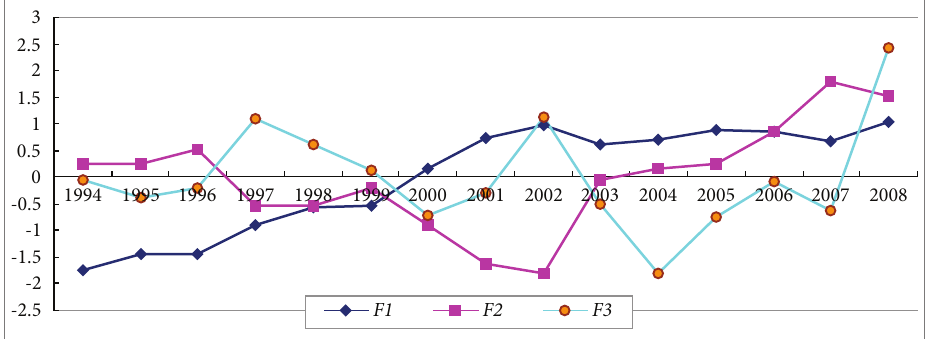
Fig. 3. Individual Component Scores of Qingdao Science Park